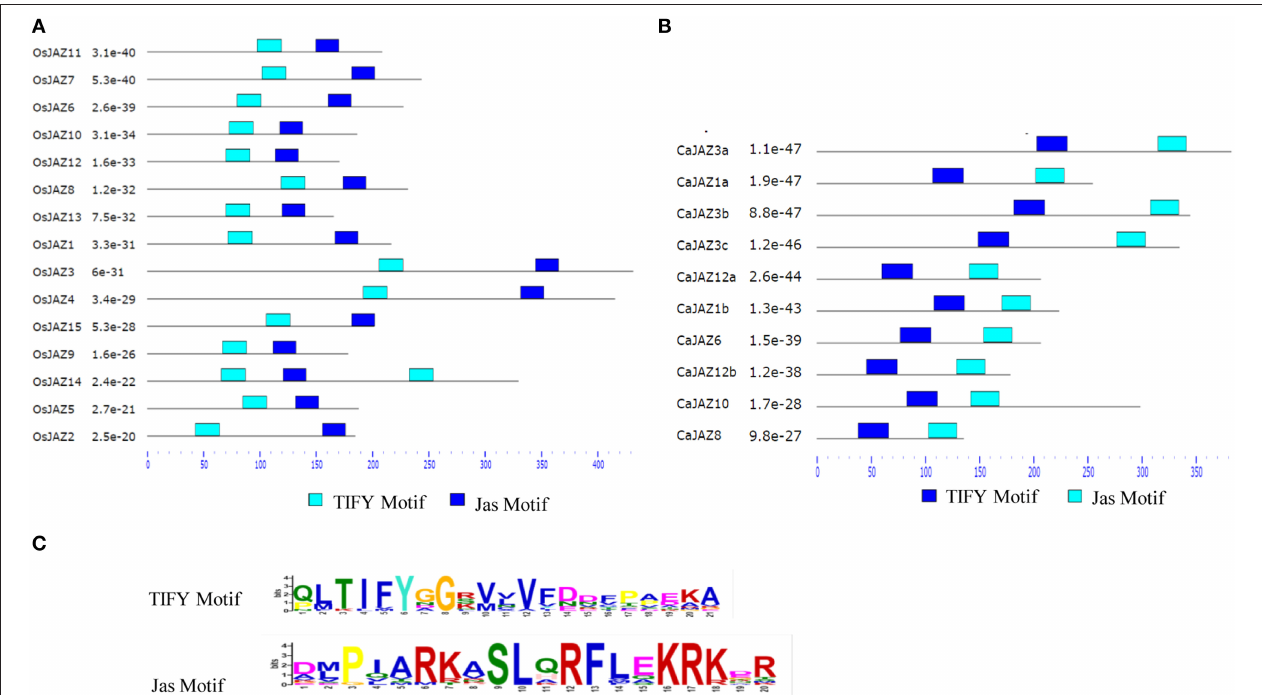
FIGURE 2 | Putative conserved motif distribution in (A) OsJAZ and (B) CaJAZ proteins. Domains of OsJAZ and CaJAZ proteins were investigated using the MEME web server (www.meme-suite.org). Color blocks represent the position of motifs on corresponding proteins. (C) The consensus sequence of TIFY and Jaz motif from chickpea and rice JAZ